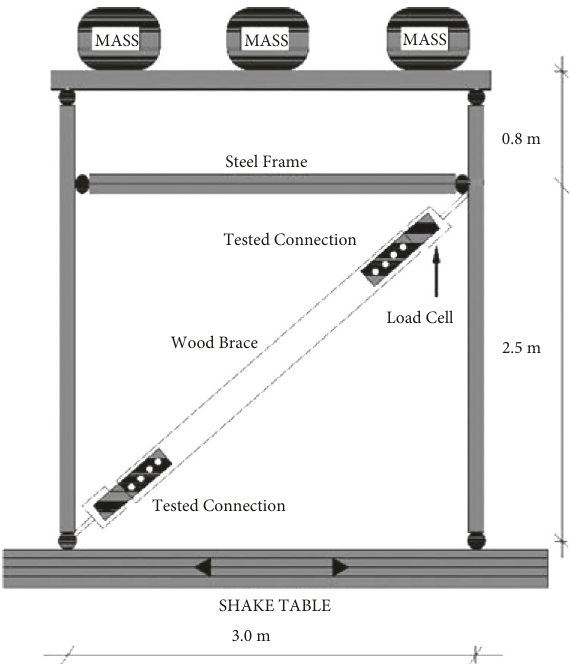
Figure 13: Test setup for the shake table tests